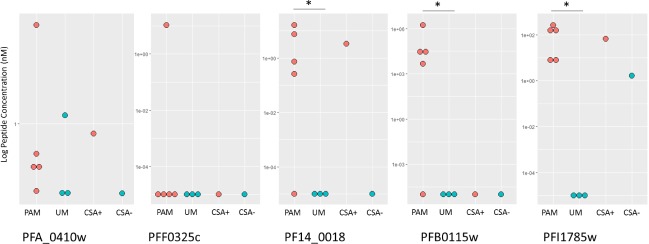
Peptide concentration measured within calibration range of each peptide.Peptide concentrations calculated by linear regression for each studied protein, y axis presents peptide concentration. Each dot represents one sample, and reference strains are displayed separately on the right of each plot (CSA+: CSA adhesion selected parasite strain, CSA-: non selected parasite strain). PAM samples and CSA+ parasite strains display a placental malaria like binding phenotype (in red), and UM samples and CSA- parasite strain display a uncomplicated malaria phenotype (in blue). PF14_0018, PFA_0410w, PFB0115w and PFI1785w are preferentially found in PAM like samples.